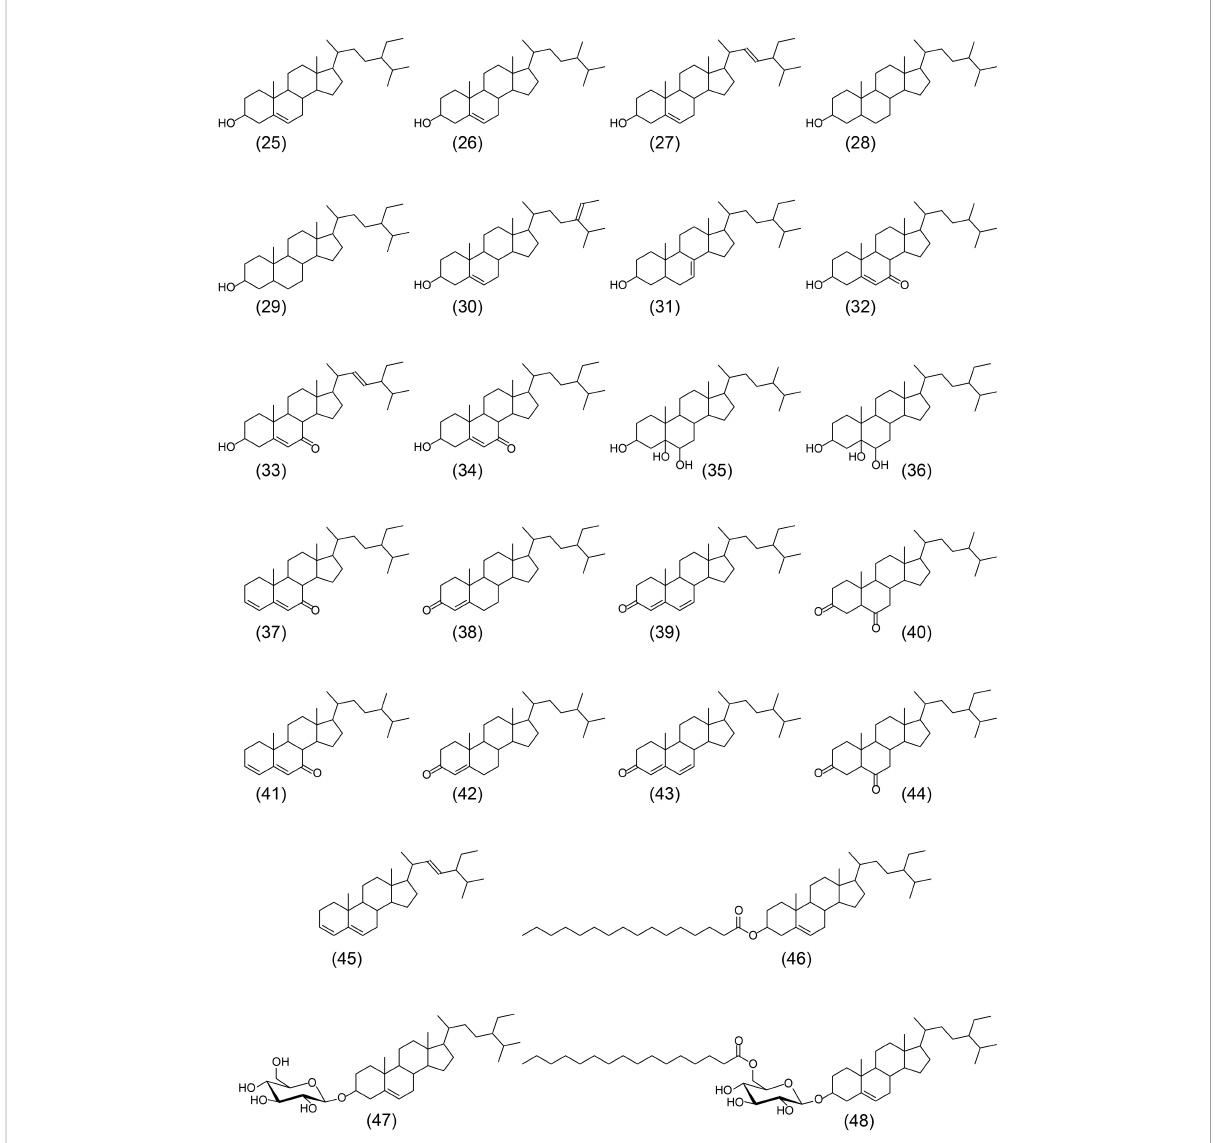
FIGURE 4 Structures of the main steroid compounds identi fi ed in the acetone extracts of the rind and pith of papyrus stems and referred in the text. 25: sitosterol; 26: campesterol; 27: stigmasterol; 28: campestanol; 29: stigmastanol; 30: D 5 -avenasterol; 31: D 7 -stigmastenol; 32: 7-oxocampesterol; 33: 7-oxo-stigmasterol; 34: 7-oxositosterol; 35: ergostane-3,5,6-triol; 36: sitostane-3,5,6-triol; 37: stigmasta-3,5-dien-7-one; 38: stigmast-4- en-3-one; 39: stigmasta-4,6-dien-3-one; 40: stigmastane-3,6-dione; 41: ergosta-3,5-dien-7-one; 42: ergost-4-en-3-one; 43: ergosta-4,6- dien-3-one; 44: ergostane-3,6-dione; 45: stigmasta-3,5,22-triene; 46: sitosteryl hexadecanoate; 47: sitosteryl 3- O - b - D -glucopyranoside; 48: sitosteryl (6 ’ - O -palmitoyl)-3- O - b - D